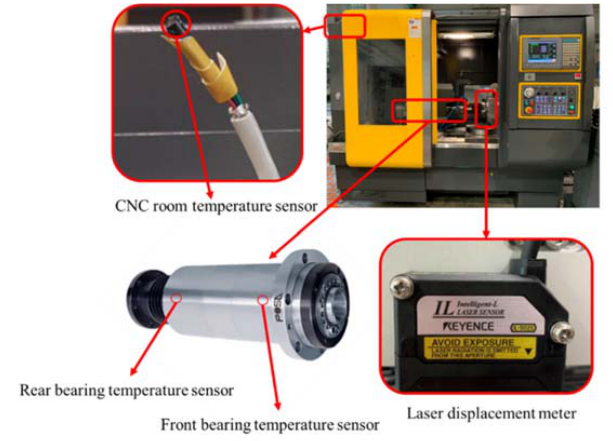
Figure 1. Position of the front and rear bearing temperature sensors, the room temperature sensor and the laser displacement meter.